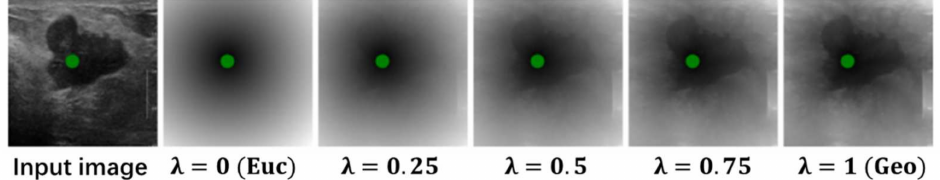
Figure 2. An example of weighted distance maps when λ in (3) takes different values. The green point is the foreground interaction